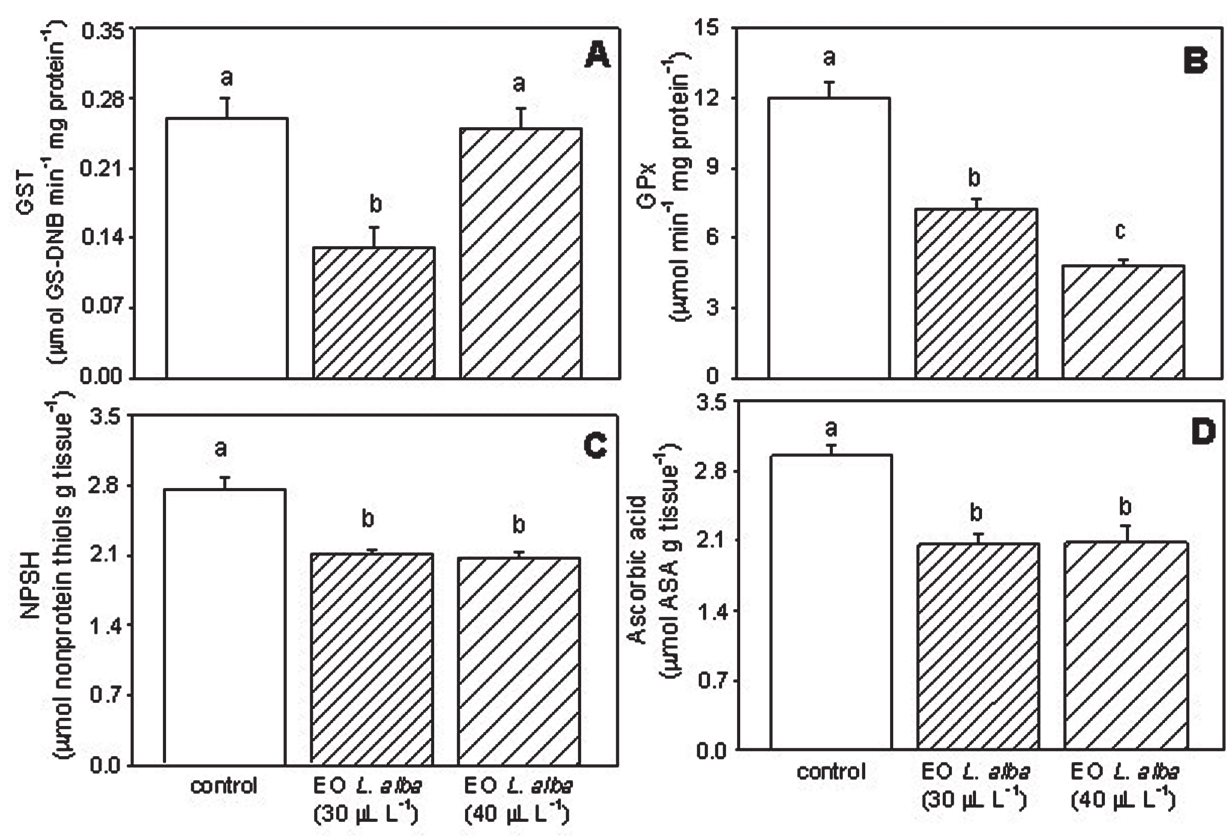
Fig. 2. Glutathione-S-transferase (GST) activity (A), glutathione peroxidase (GPx) activity (B), non-protein thiol group (NPSH) content (C) and ascorbic acid (D) content in the liver of silver catfish ( Rhamdia quelen ) transported in plastic bags containing water treated with the essential oil from Lippia alba . The values are expressed as the means ± SEM. Different letters indicate levels of significance between the treatments (P<0.05).